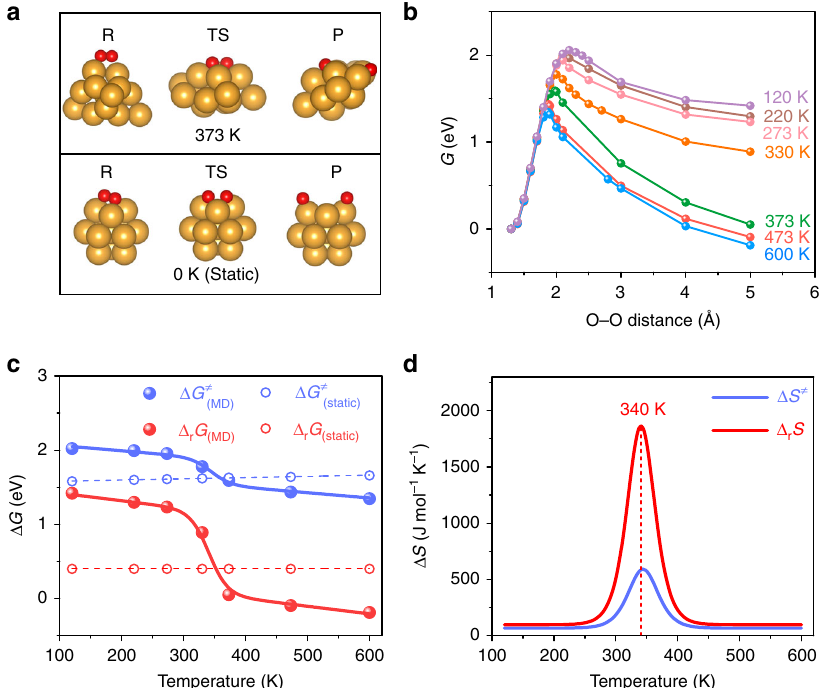
Fig. 1 Reaction free energies of O 2 dissociation on Au 13 . a Upper: snapshots of the structures calculated using AIMD at 373 K. Down: structures calculated by static geometry optimization. R, TS and P denote the reactant, transition state and product state, respectively. The balls in yellow and red represent Au and O atoms, respectively. b The free energy pro fi les of O 2 dissociation on Au 13 under different temperature calculated using AIMD. c Temperature dependence of reaction free energies ( Δ r G, red) and free energy barriers ( Δ G ‡ , blue). Free energies are referenced to those of the reactant states. The fi lled and hollow circles represent the calculated energies using AIMD and static geometry optimization method, respectively, and the solid and dash curves are the corresponding fi ts. d Temperature dependence of the reaction entropy changes ( Δ r S) and activation entropies ( Δ S ‡ ) calculated by AIMD. The insert value indicates the temperature of maximum entropy